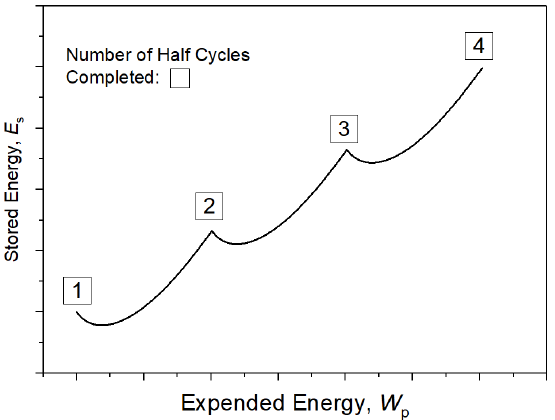
Figure 1. The evolution of stored energy versus accumulated plastic work during cyclic loading for metal.